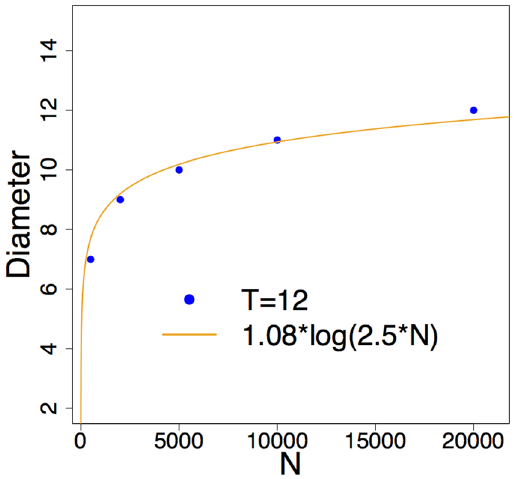
Figure 4. Small world property of T = 12 networks. The diameter of the network grows logarithmically with the number of nodes.